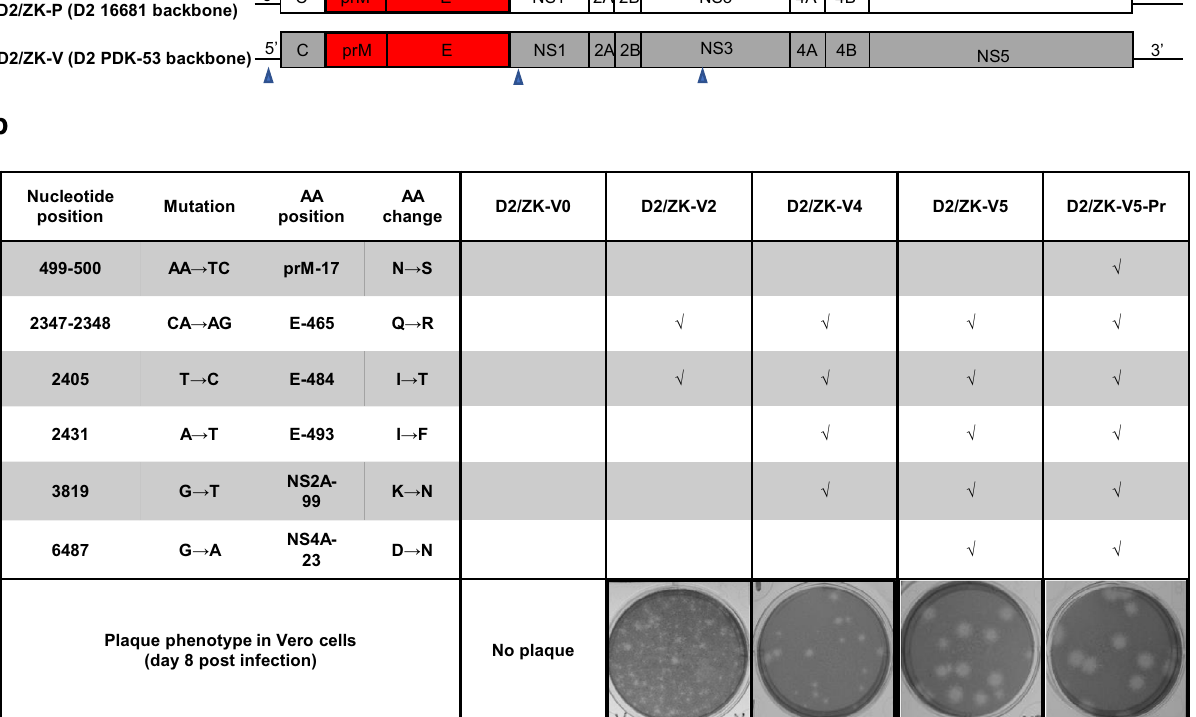
Fig. 1 Genomic organization and modi fi cation of chimeric D2/ZK viruses. a Genomic map of the D2/ZK viruses with prM-E of ZIKV SPH in the genomic background of either DENV-2 16681 (D2/ZK-P, parental) or DENV-2 PDK-53 (D2/ZK-V, vaccine). Blue triangles denote the 3 primary PDK-53 attenuation loci, 5-NCR c57t, NS1-G53D and NS3-E250V. b Genetic substitutions and plaque images of several D2/ZK-V viruses. Engineered mutations and a representative image of plaque morphology in Vero cells are indicated for each